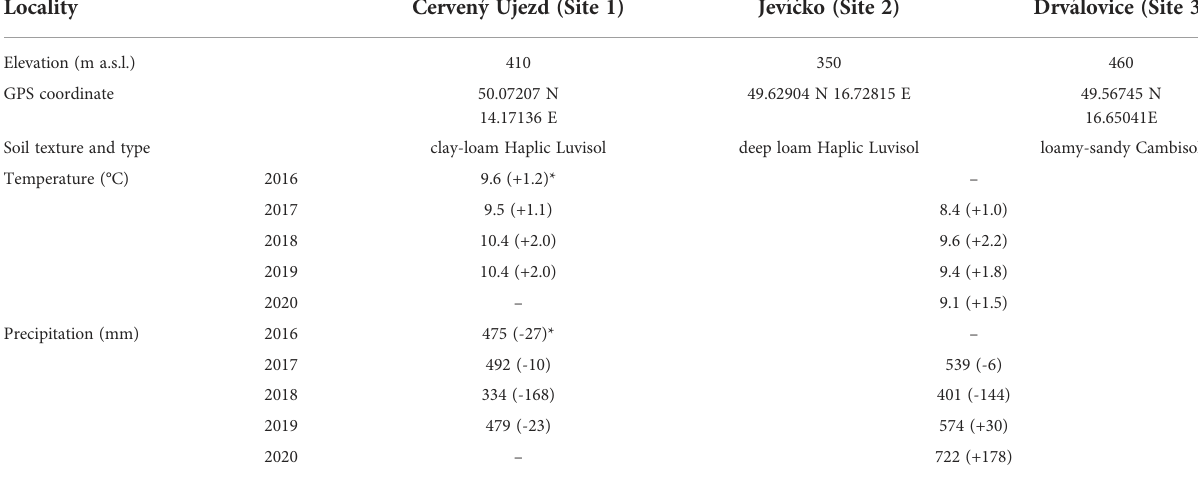
TABLE 1 Description of localities, annual temperature mean and cumulated precipitation.